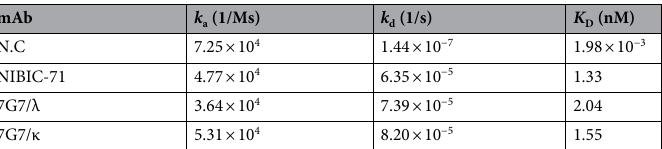
Table 2. Kinetic parameters from SPR analysis. N.C. indicated the negative control antibody which have no specificity for the S protein. SPR: surface plasmon resonance, mAb: monoclonal antibody, ka: association rate constant, kd: dissociation rate constant, KD: dissociation